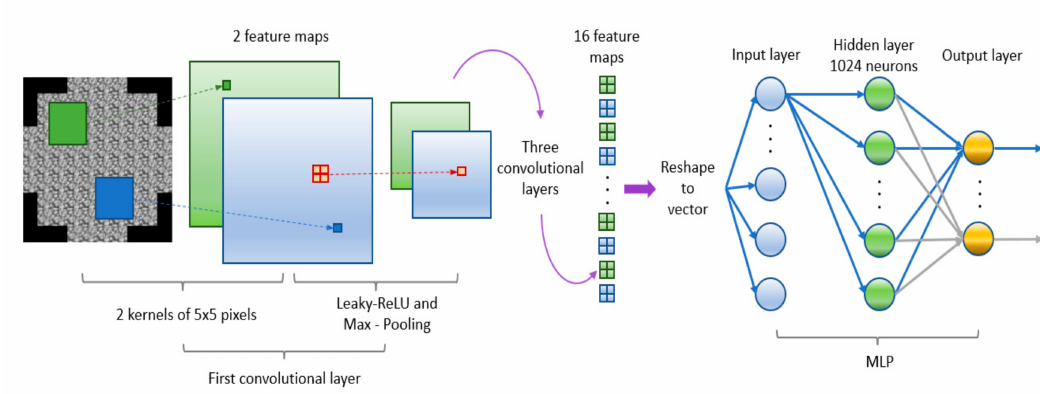
Figure 4. Topology and implementation of Shack-Hartmann reconstruction with deep learning on solar–prototype (proto-HELIOS). The architecture consists of four sets of convolutional layers of two kernels each, followed by Leaky-ReLU and Max-Pooling. After the convolutional process, output feature maps are reshaped to a vector and connected to a Multi-Layer Percepton